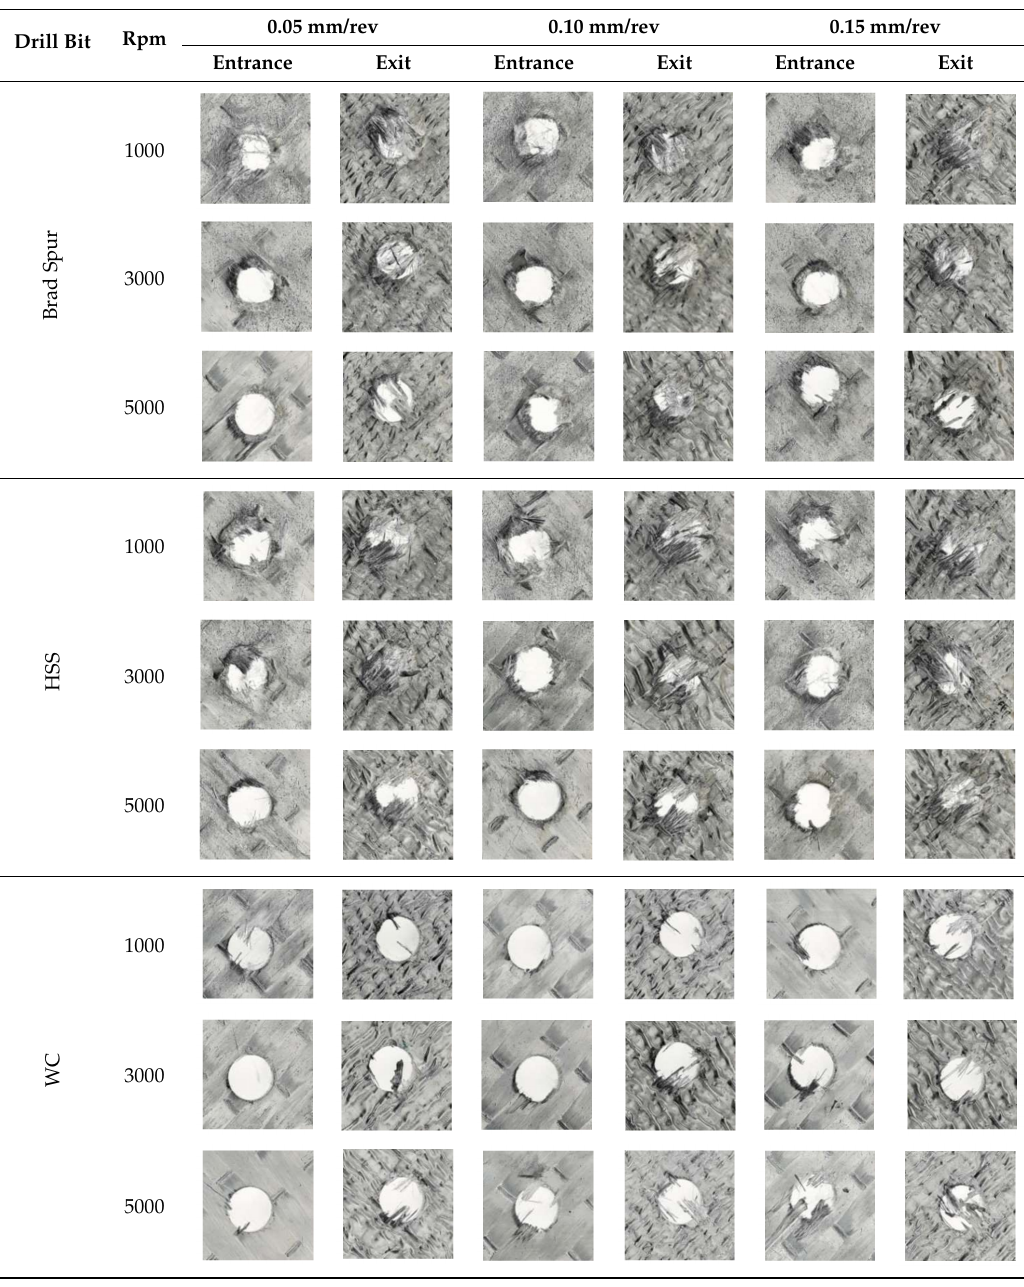
Table 4. The Delamination images of